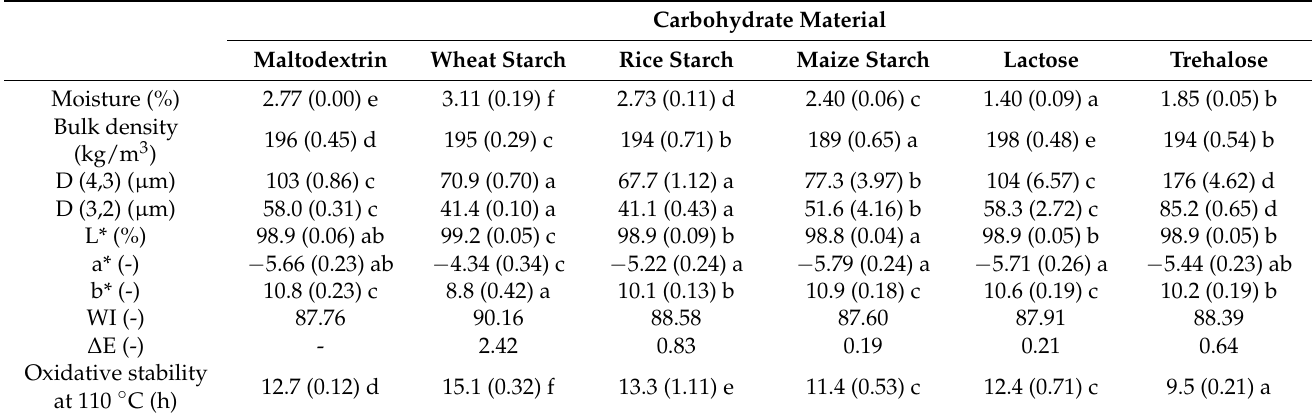
Table 3. Moisture content, physical properties and oxidative stability of encapsulated pumpkin oil in carbohydrate